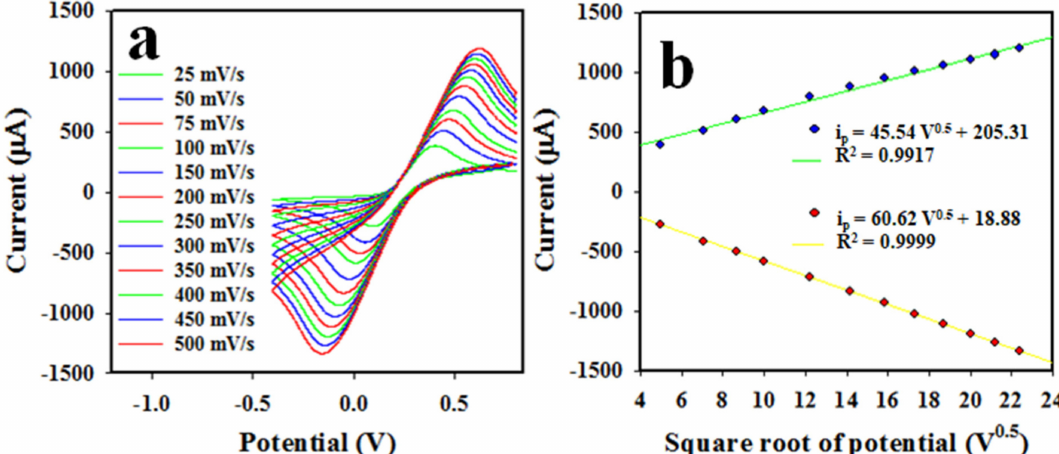
Figure 6. Electrochemical investigation of Nafion/CuO/ZnO NSs/GCE. ( a ) Scan rate of assembled working electrode based on CuO/ZnO NSs in CV analysis of 0.1 mM ferricyanide/ferrocyanide, in a pH 7.0 buffer. ( b ) V 1/2 versus i p